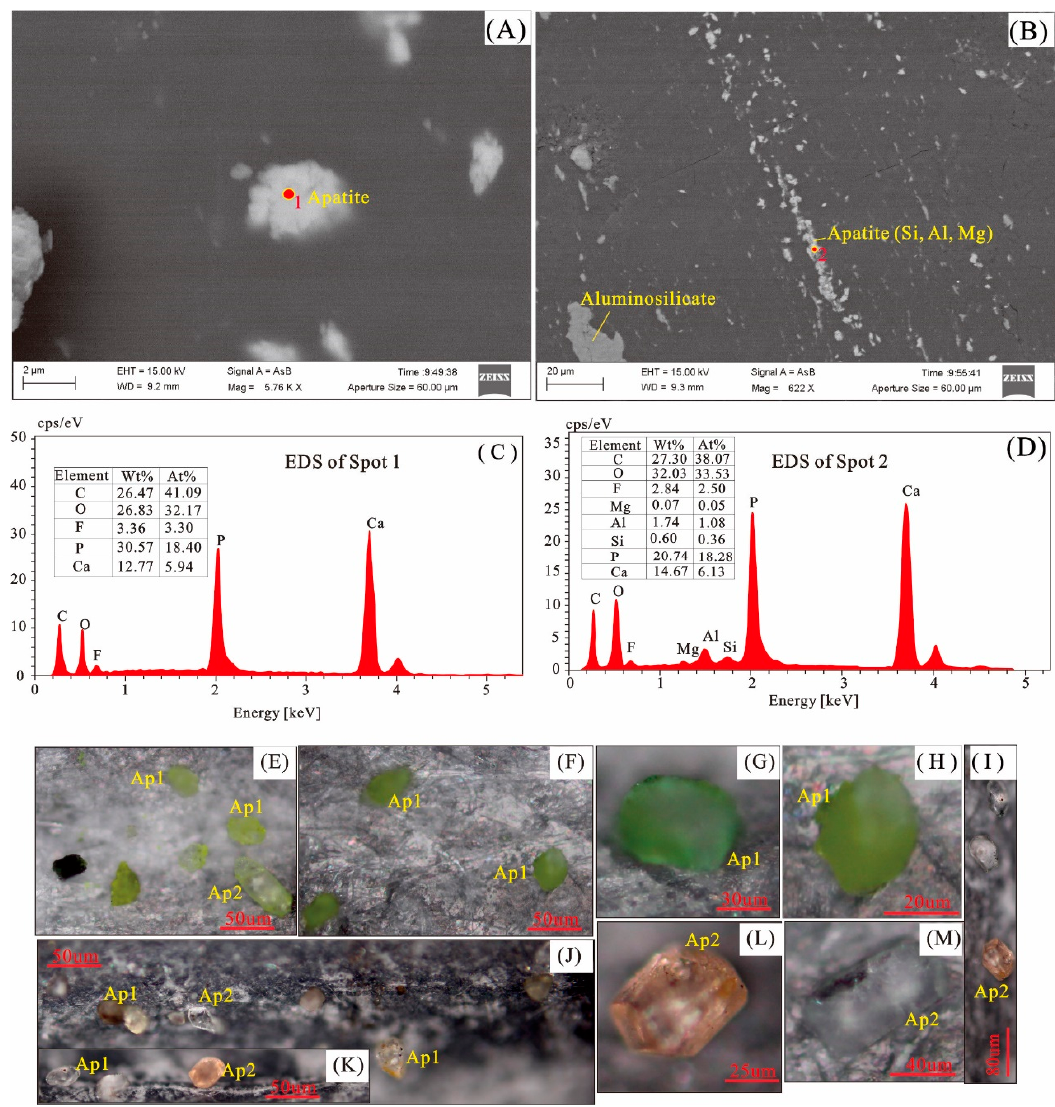
Figure 10. Characteristics of apatite grains from Dongpo Mine ( A – D ) under SEM ( E – M ) single apatite crystals under reflected light. ( A ) Apatite in sample DP5 -2 -8. ( B ) Composite particles of apatite and aluminosilicate minerals in sample DP5 -2 -8. ( C ) EDS spectrum of Spot 1. ( D ) EDS spectrum of Spot 2. ( E – M ) apatite in samples DP5 -2 -8 and DP5 -2 -5. Ap1 rounded single apatite crystals. Ap2 euhedral and hexagonal single apatite crystals.